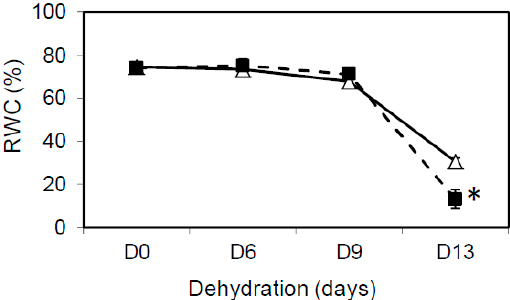
Figure 2. Effect of water stress on the relative water content (RWC, in %) in Col-0 (open triangles) and the double mutant trxy1y2 (dark squares). Means ± SD are the average of 6 biological repeats from 2 independent experiments ( n = 6). The asterisk (*) indicates a mutant sample significantly different from WT ( p < 0.05).